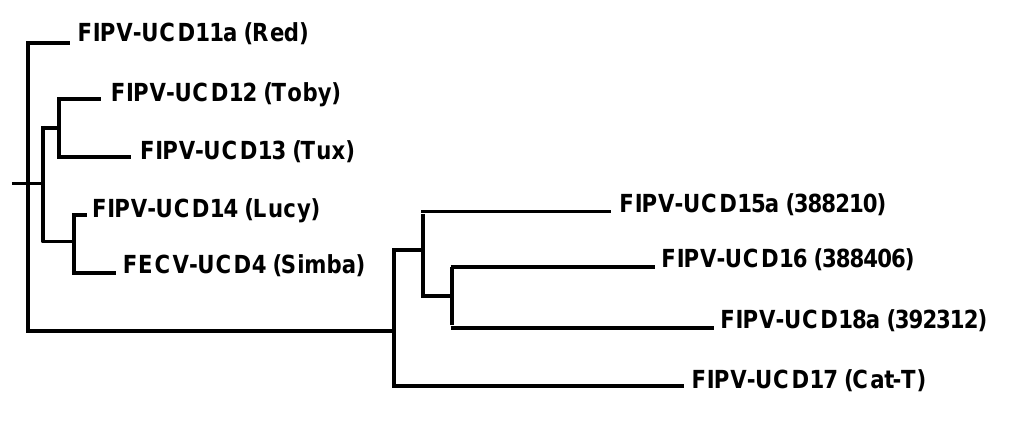
Figure 1. Phylogenetic analysis based on the sequences encoding for structural (E, M and N) and accessory (3a-c and 7a,b) genes. FIPV-UCD11a, 12, 13, and 14, and FECV-UCD4, were isolated from 4 related kittens and a healthy housemate. FIPV-UCD15a, 16, 17, and 18a were isolated from unrelated and geographically disparate cats.